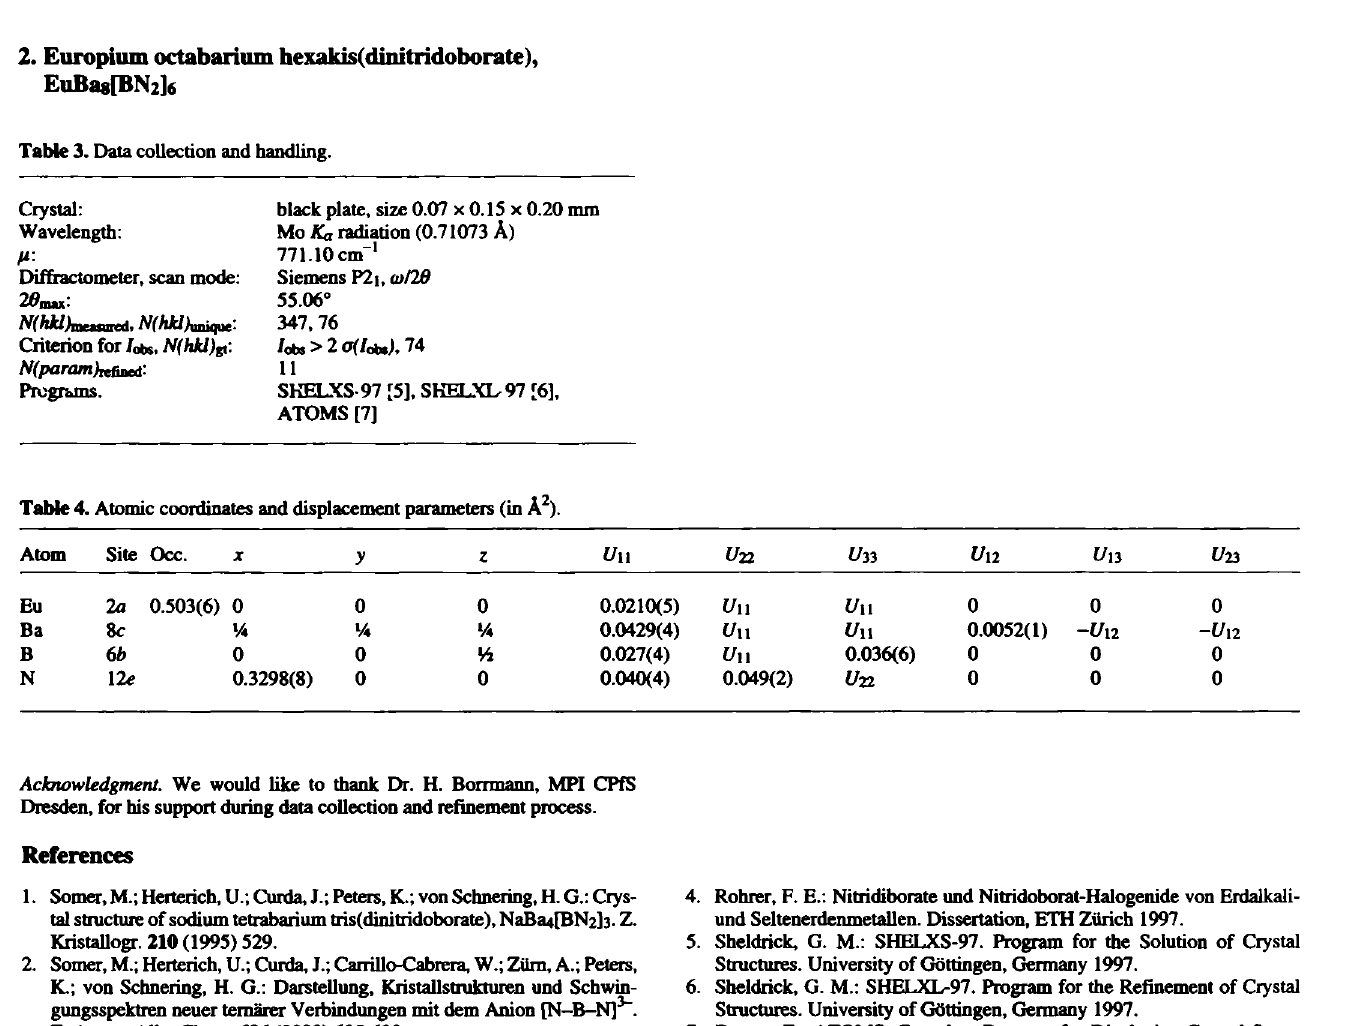
Table 4. Atomic coordinates and displacement parameters (in A 2 ). Atom Site